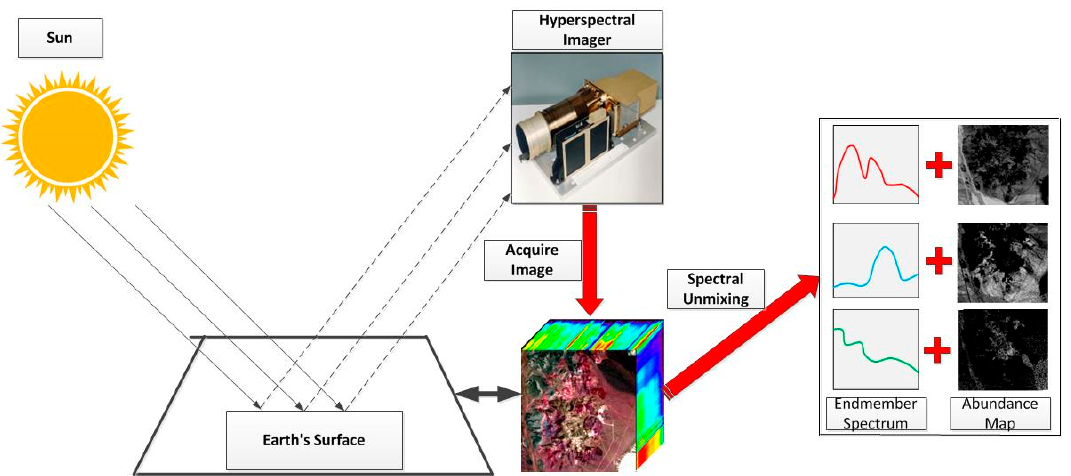
Figure 1. Schematic overview of hyperspectral image acquisition and spectral unmixing.